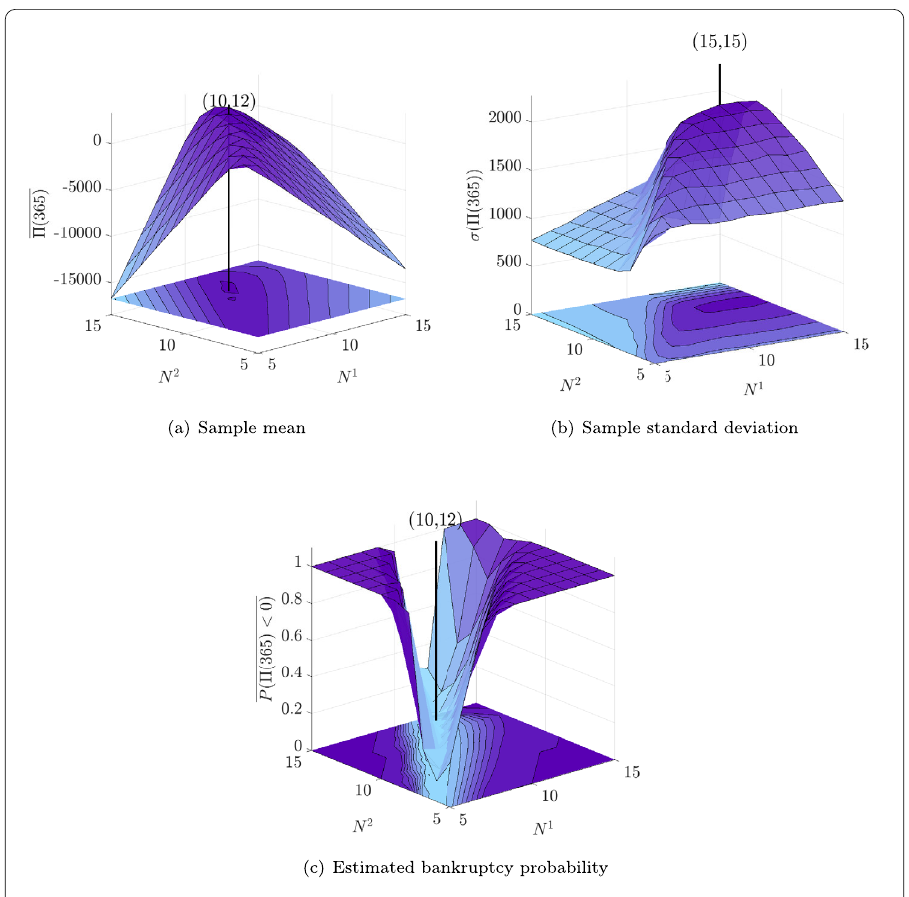
Figure 8 Profit evaluation for different cluster sizes